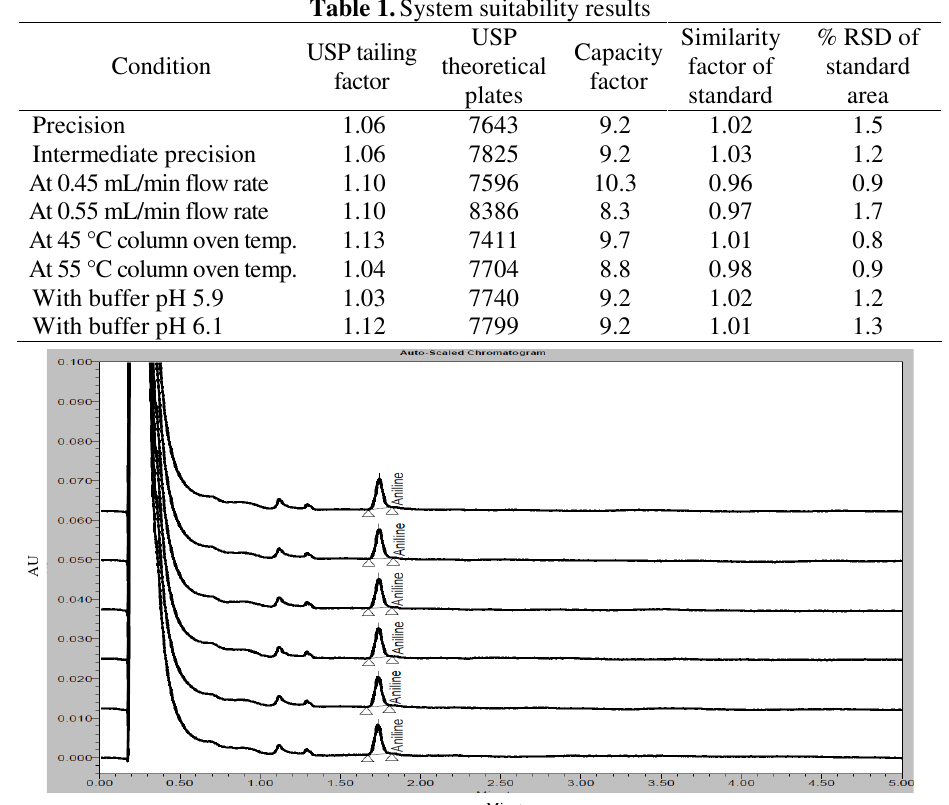
Table 1. System suitability results